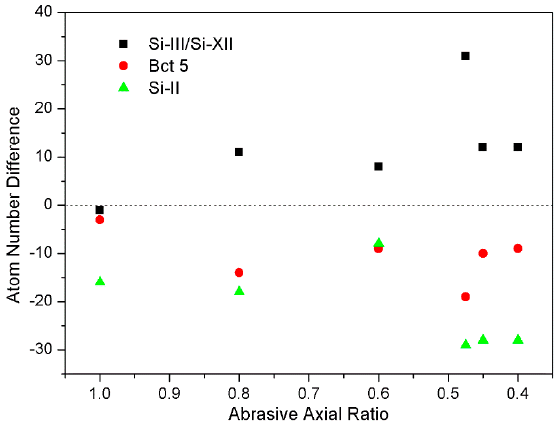
Figure 8. Number difference of the transformational atoms induced by loading to the remaining atoms at the instant of 20 ps from the particle starting to move off.